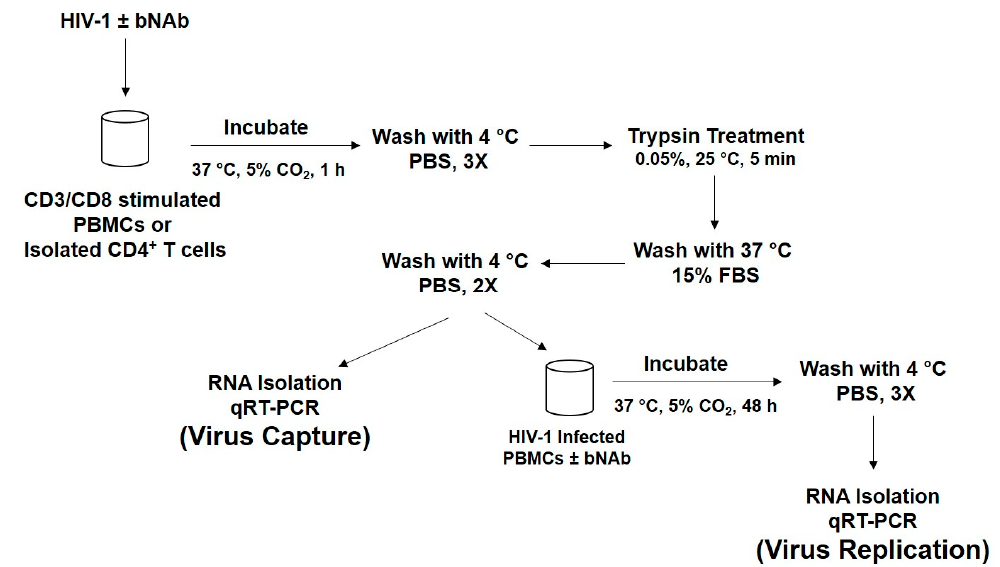
Figure 1. Scheme of the virus capture and replication assay. CD3 / CD8 stimulated PBMCs or isolated CD4 + T cells were infected with virus (or virus pre-incubated with bNAb) for 1 h at 37 ◦ C / 5% CO 2 . The cells were washed three times with cold PBS, and then treated with 0.05% trypsin at room temperature for 5 min. The cells were washed three times and the remaining pellet was used for RNA isolation and qRT-PCR analysis. Cells that were used to examine virus replication were resuspended in media after the trypsin treatment, washed, and incubated for 48 h at 37 ◦ C / 5% CO 2 . The cells were then washed three times with cold PBS and then processed for RNA isolation and qRT-PCR analysis.